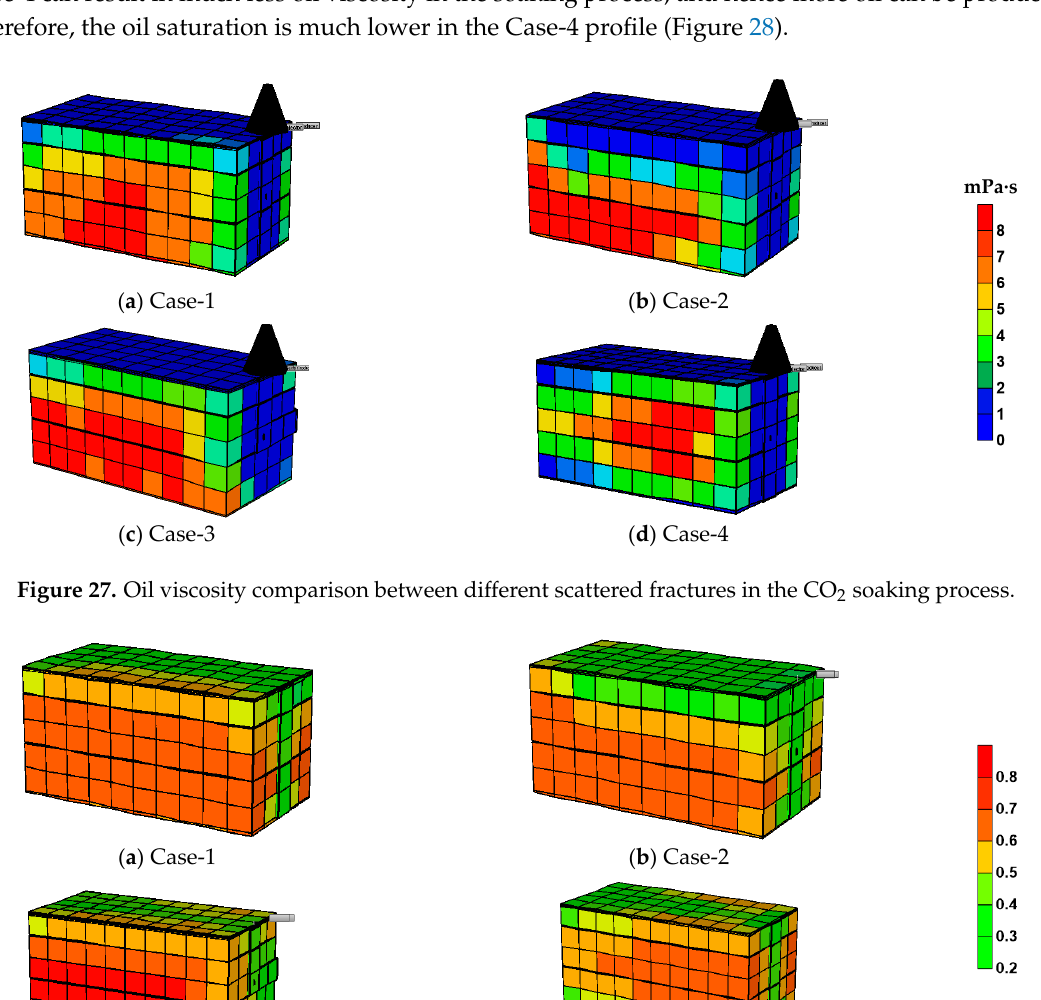
Figure 26. Oil recovery comparison between different scattered fractures.